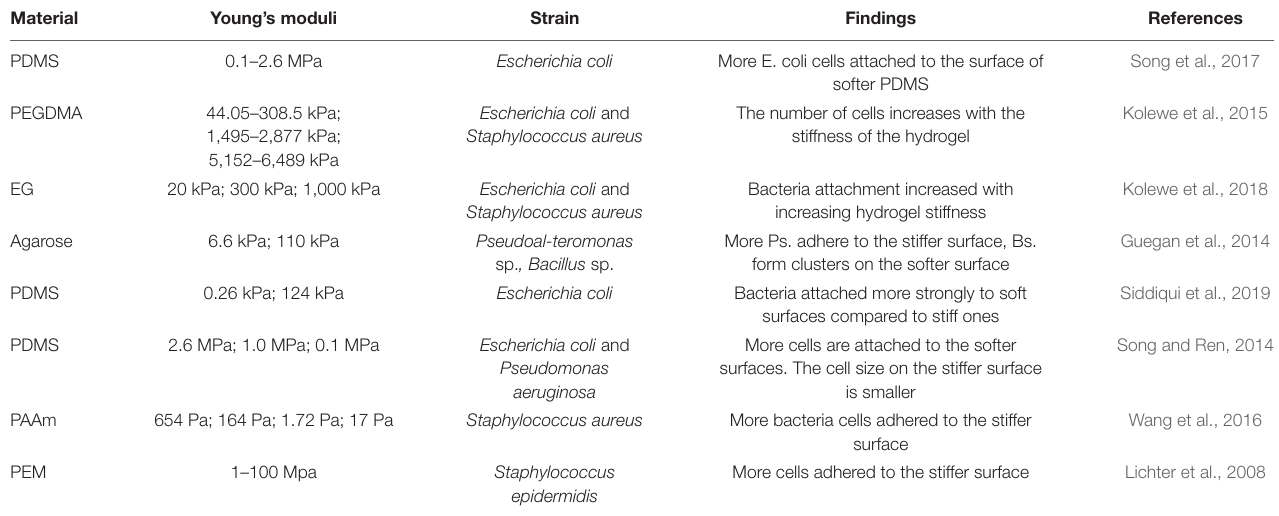
FIGURE 2 | Studies focused on different substrate moduli ranges in bacteria adhesion. TABLE 3 | Summary of the effects of substrates’ stiffness on biofilm adhesion